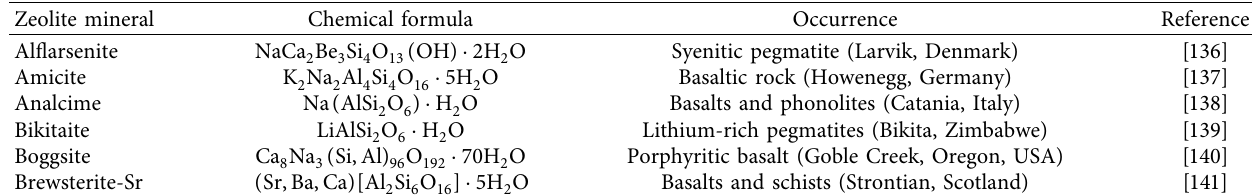
Table 2: Summary of occurrence of some